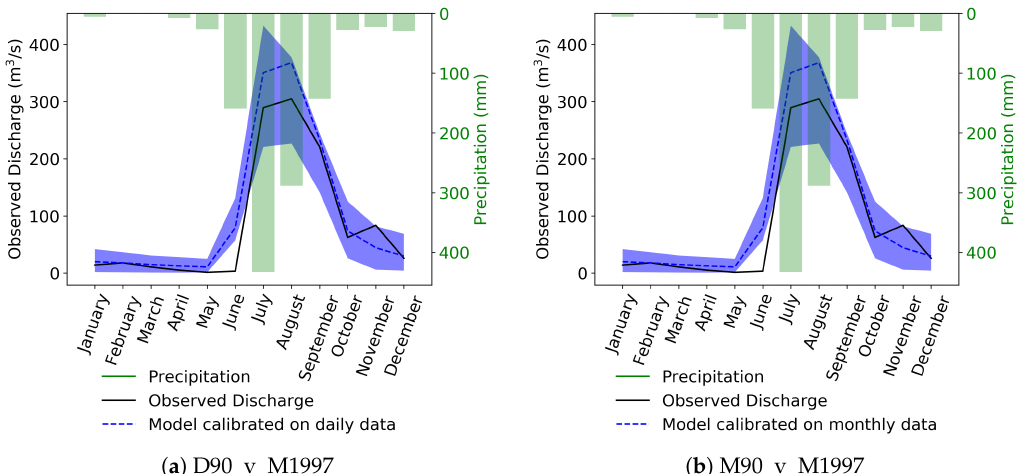
Figure 4. Time-series comparison of SWAT simulated and observed basin outlet monthly discharges for the year 1997, developed using calibrated parameter sets of the calibration cases ( a ) D90 (D90_v_M1997) and ( b ) M90 (M90_v_M1997). The blue band indicates the 95PPU range of simulated discharge; the dotted line indicates the simulation corresponding to the ‘best’ parameter set; and observations are represented by the solid